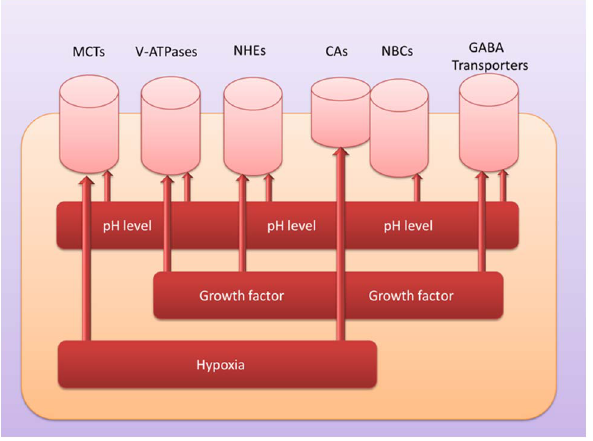
Figure 5. A model for deacdification in cancer cells. Each cylinder represents a pump or transporter used to remove protons and possibly other molecules out of the cell; and each rectangle bar represents a condition that is a possible regulatory factor for the corresponding pump or transporter.